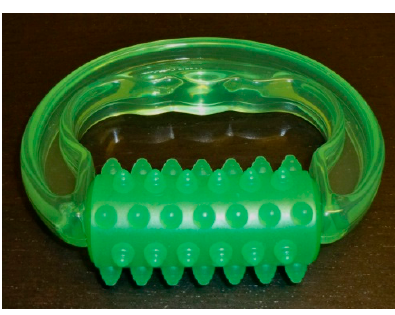
Figure A3. Massager.